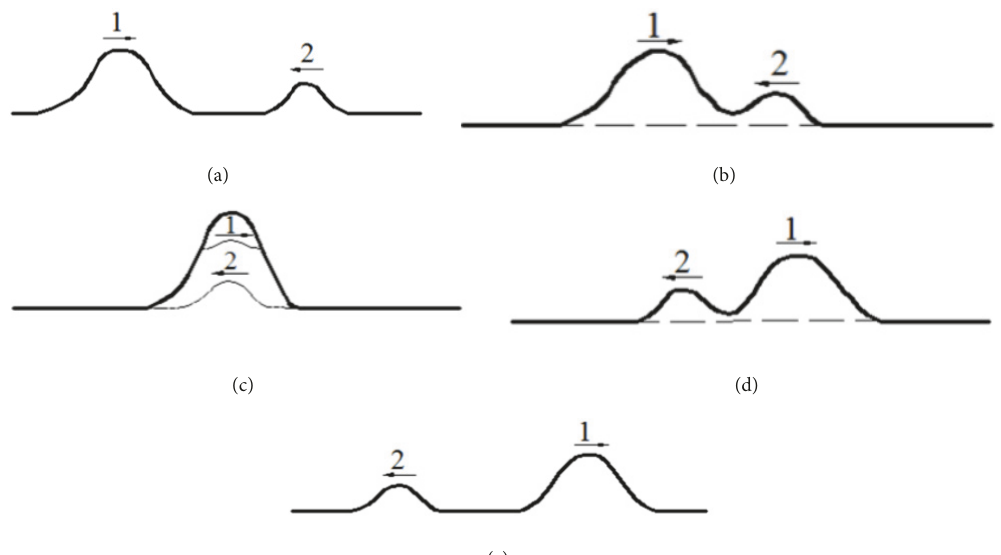
Figure 7: Wave superposition principle.